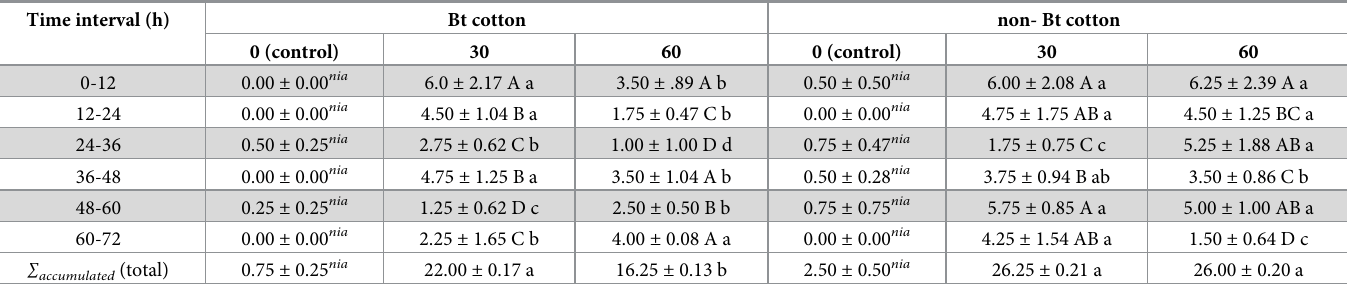
Table 1. Number of variation potentials emitted (mean ± SE) by Bt and non-Bt cotton plants when subjected to different exposure times and densities of A . gossy- pii /plant.